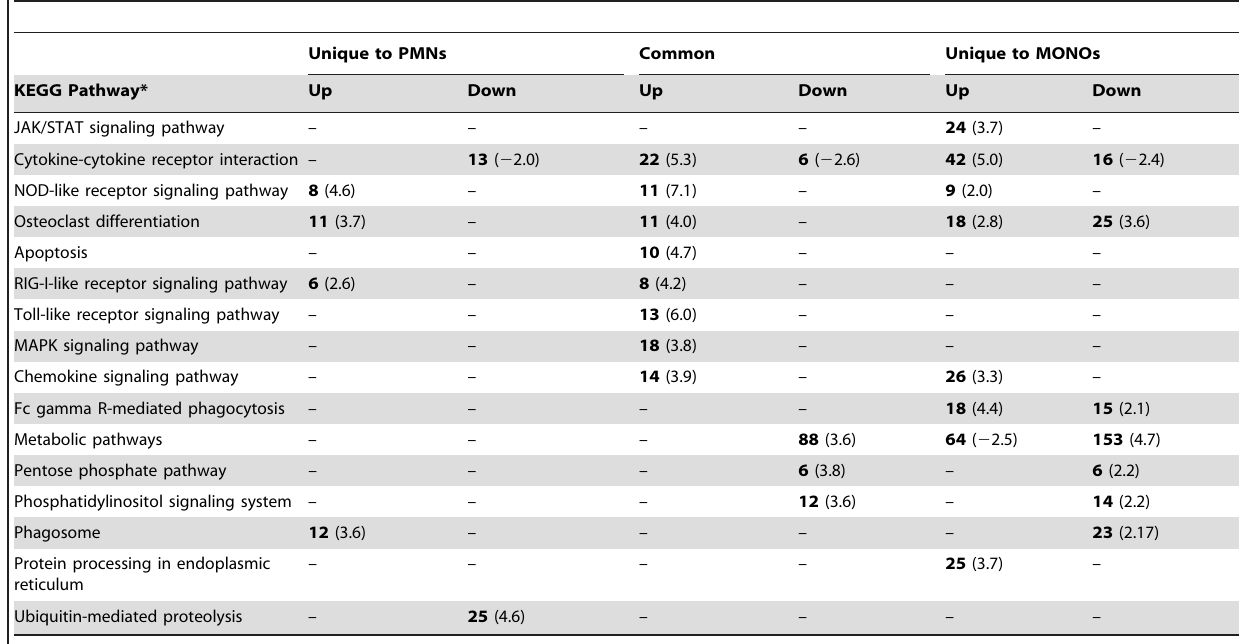
Table 3. Pathways for genes changing expression (fold changes) measured by genome-wide microarray after 4 h of endotoxin